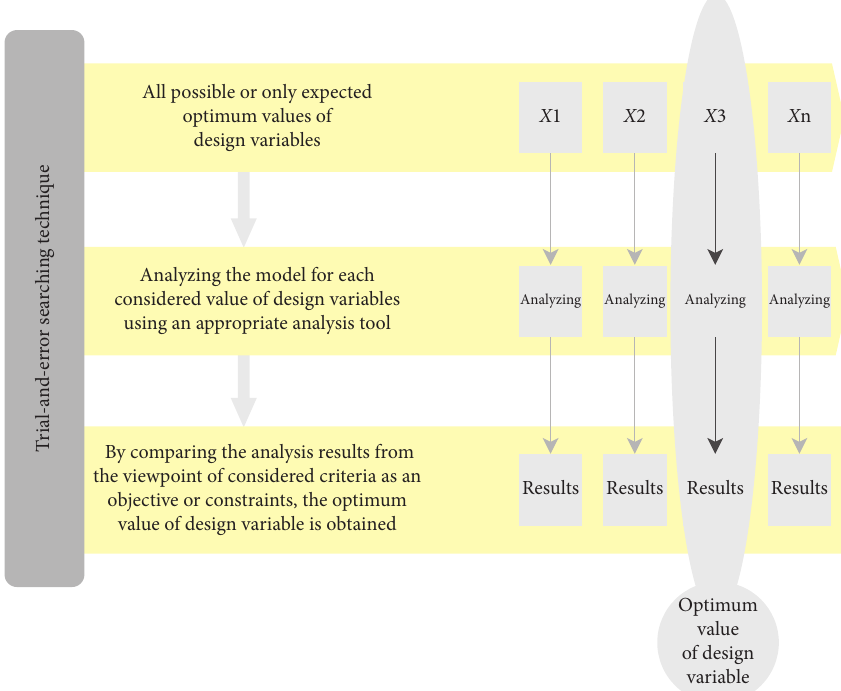
Figure 11: Trial-and-error searching